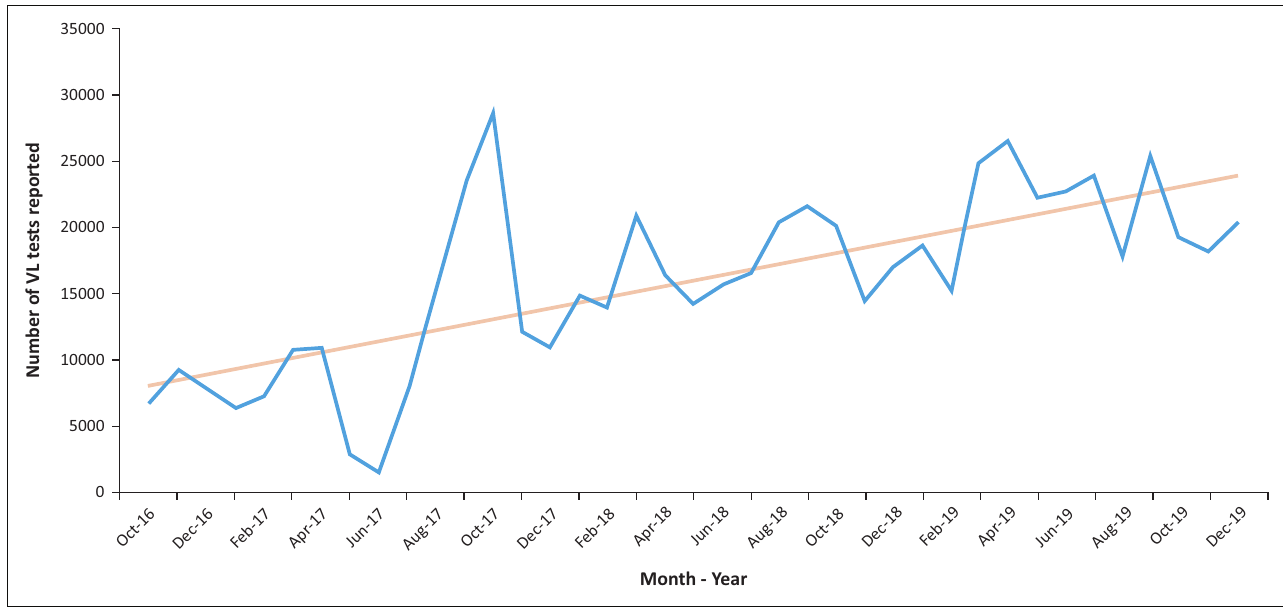
VL, viral load. FIGURE 3: Number of viral load tests reported in Côte d’Ivoire, October 2016 – December 2019. The viral load dashboard captured all viral load testing data since its beginning in Côte d’Ivoire, October 2016. As the country committed to scaling up viral load testing access to people living with HIV, the number of total tests increased. The data represented above show this trend, which is expected to continue.